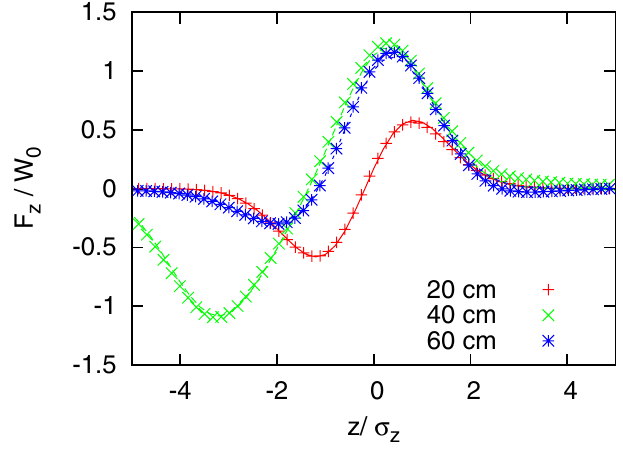
FIG. 4. (Color) Longitudinal force as a function of z (taken at x; y (cid:1) 0 ) from CSR in transient states (measured in distance traveled past the entrance) from simulation (symbols) compared to vacuum theory (lines) for a three-dimensional Gaussian bunch in a 30 (cid:8) 30 cm rectangular waveguide with a uniform bending radius of 120 cm. The longitudinal coordinate z is scaled to the , which is 0.23 cm, and the force is scaled to rms bunch length (cid:4) z (cid:1) (cid:1)(cid:1)(cid:1)(cid:1)(cid:1)(cid:1)(cid:1)(cid:1)(cid:1) 2 =(cid:2) p Ne 2 (cid:2) 3 R 2 (cid:4) 4 (cid:3) (cid:4) 1 = 3 . W z 0